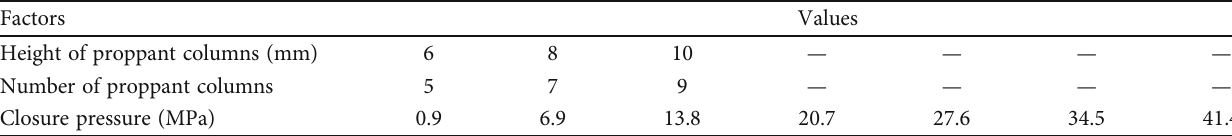
Figure 1: Schematic diagram of proppant placement for conventional hydraulic fracturing (left) and high-speed channel fracturing (right) [1]. Table 1: Value table of experimental factors.